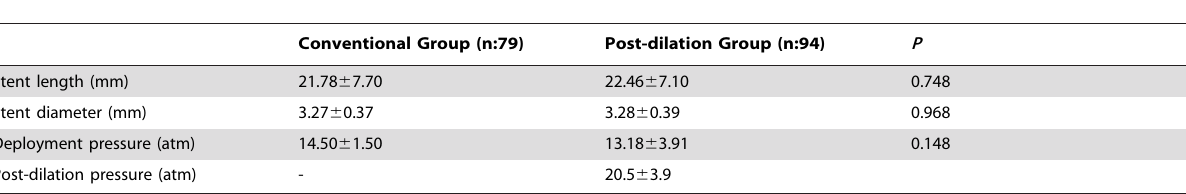
Table 3. Procedural device Parameters of Patients in both groups.